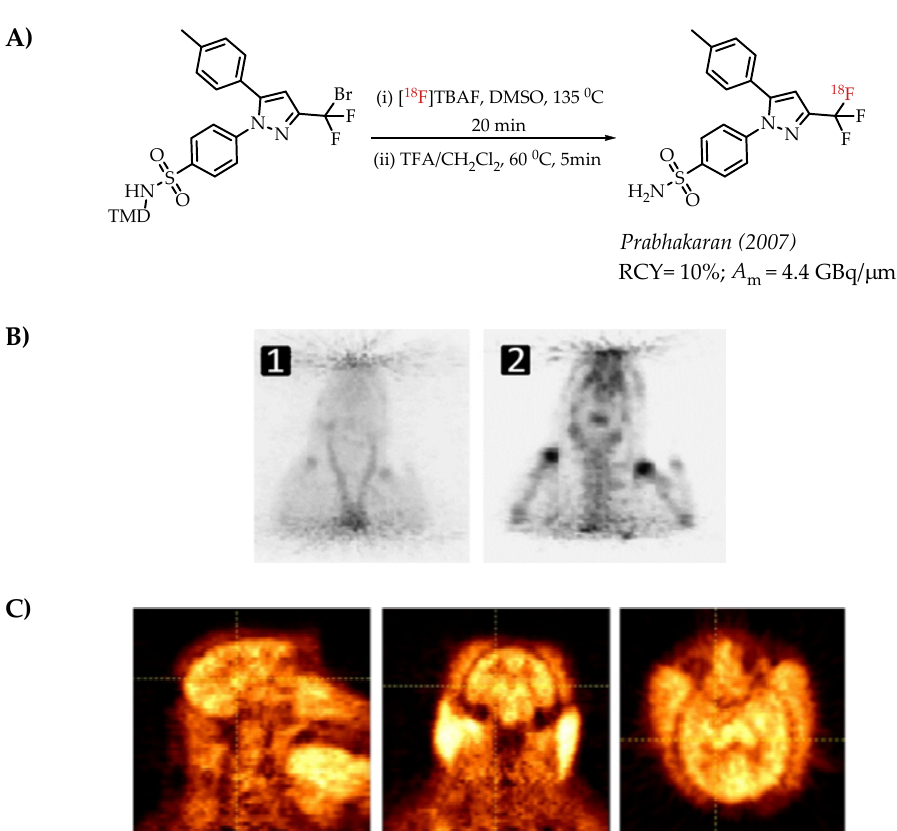
Figure 8. ( A ) Radiolabelling of celecoxib reported by Prabhakaran et al., ( B ) microPET images of [ 18 F] celecoxib in a rat. PET images of [ 18 F] celecoxib in a rat (images are normalized to the injected dose). (1) Sum of 0–20 min PET images; (2) sum of 60–120 min PET images ( C ) Sum of the (0–120 min) PET images of a baboon brain after the injection of 44 MBq of [ 18 F]Celecoxib. First column, sagittal; middle column, coronal; last column, axial views. (Adopted from [23]; RCY: radiochemical yield; A m : molar activity).